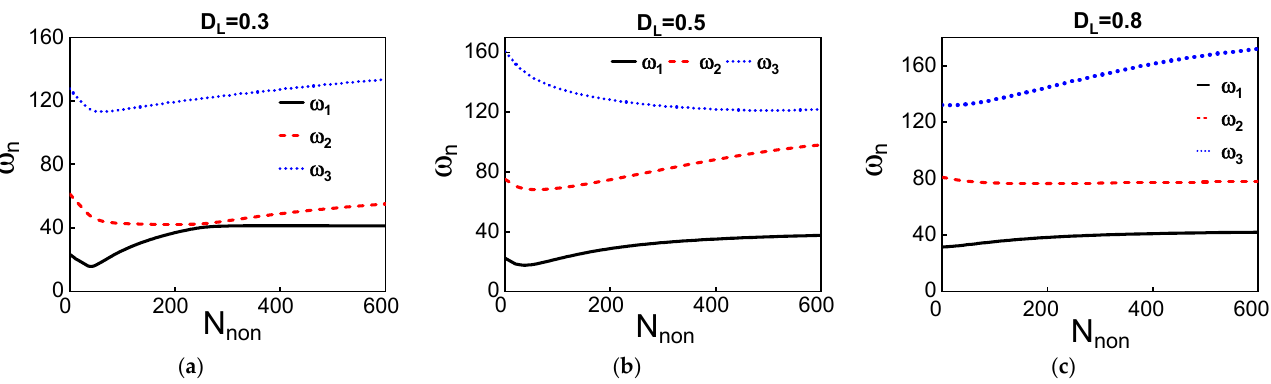
Figure 8. ( a – c ): The variation of the three lowest natural frequencies with axial load for different dome lengths, D L = 0.3, D L = 0.5, and D L = 0.8, respectively. The initial rise of the dome is equal to 3 μ m.